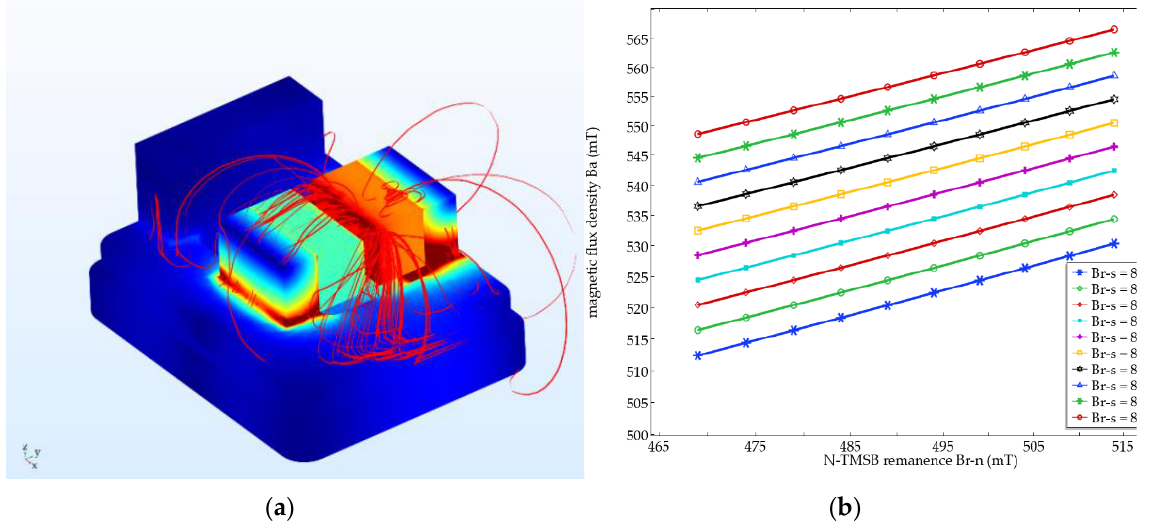
Figure 3. Simulation results. ( a ) Magnetic flux density distribution; ( b ) Influence of B r-S and B r-N on B a .